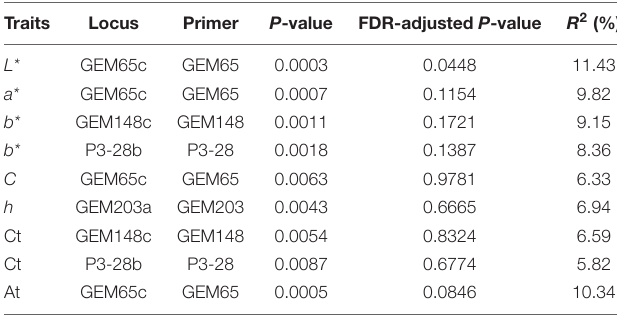
TABLE 3 | Nine loci with significant association with seven flower color traits in 123 gerbera accessions.